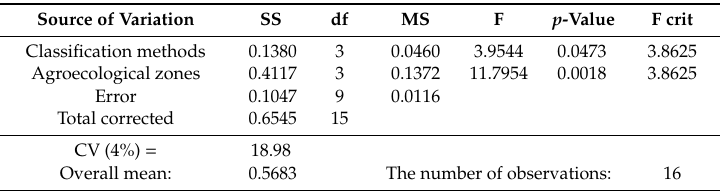
Table A3. Summary of the analysis of variance computed for the